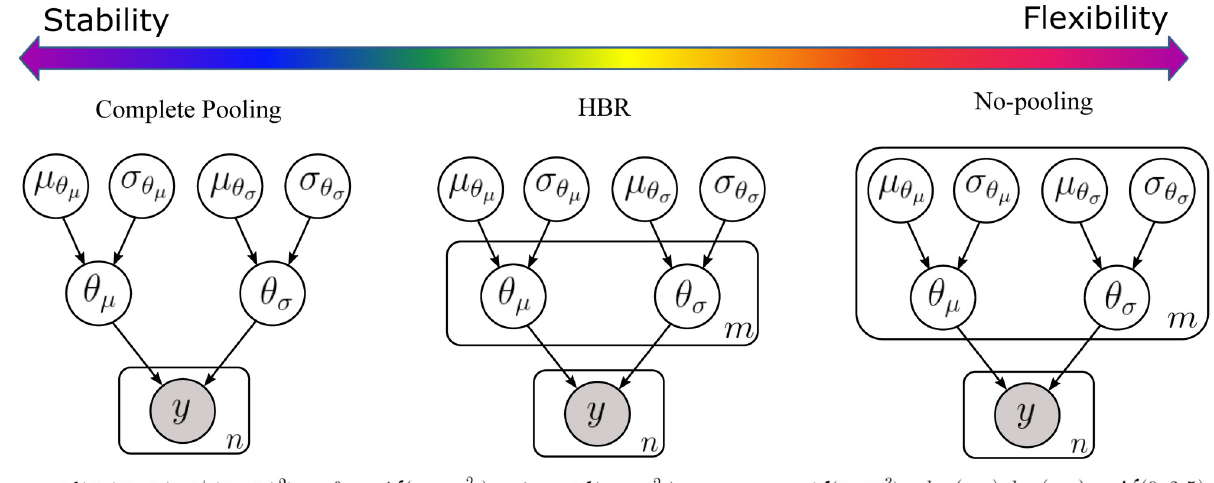
Fig 2. Graphical models of complete pooling, partial pooling via HBR, and no-pooling. The solutions for handling the site-effects form a spectrum in the model stability-flexibility space. At the stability end of the spectrum, we have the complete pooling solution. In the complete pooling scenario, the model learns the same set of parameters and hyperparameters on big data. At the flexibility end of the spectrum stands the no-pooling approach, where a large set of parameters and hyperparameters are estimated for each site, however, it does not benefit from the richness of big data. Therefore, its parameters can be unstable for sites with small sample size. The HBR lies in the middle of the spectrum, thus, it brings the best of two worlds together. In HBR, similar to no-pooling, we allow the model to learn different sets of parameters for data from multiple sites. At the same time, similar to complete pooling, the model has a fixed set of hyperparameters. Here, hyperparameters play the role of a joint prior over the parameters. They perform as a regularizer and prevent the model from overfitting on small batches.